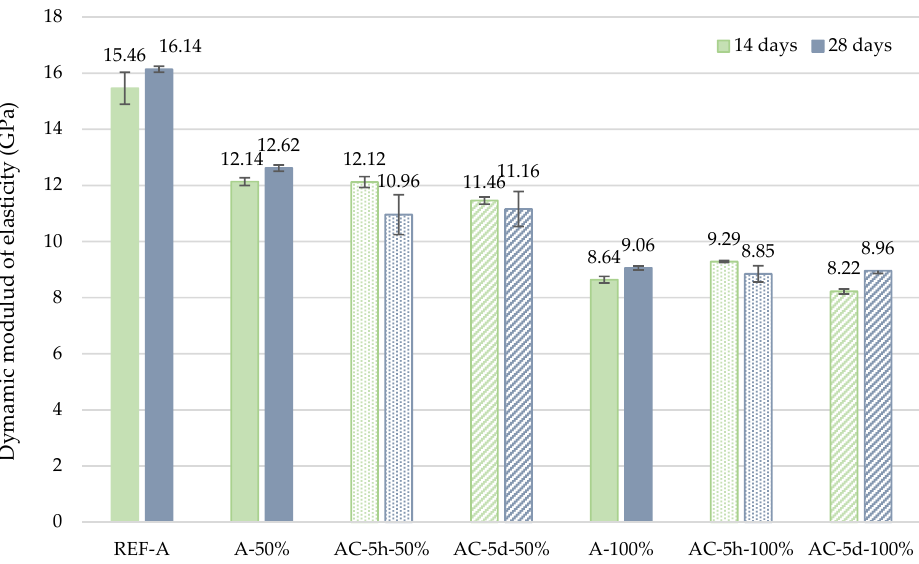
Figure 6. Dynamic modulus of elasticity results.